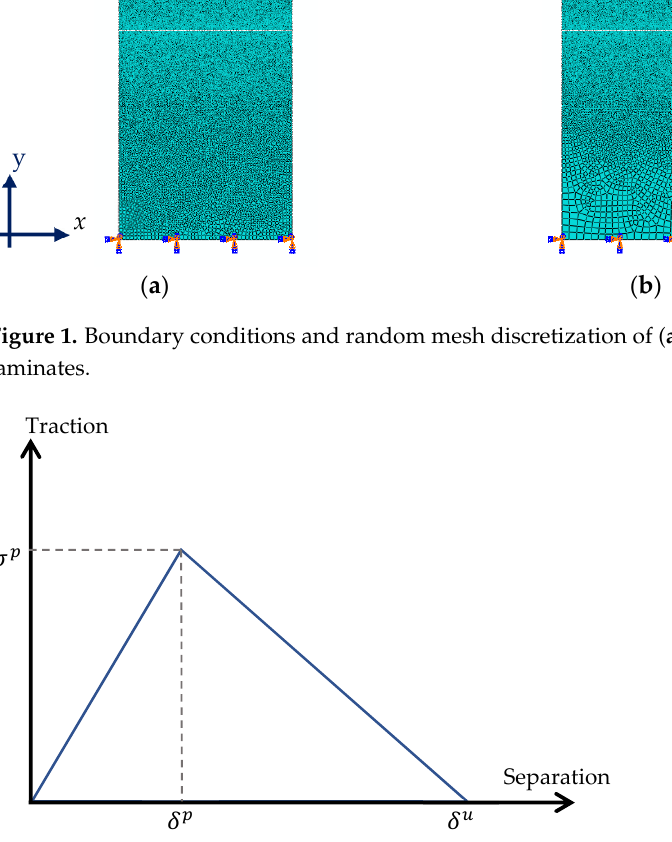
Figure 2. The T–S law is used to model the interface behavior. Table 4. Calibrated interfacial layer